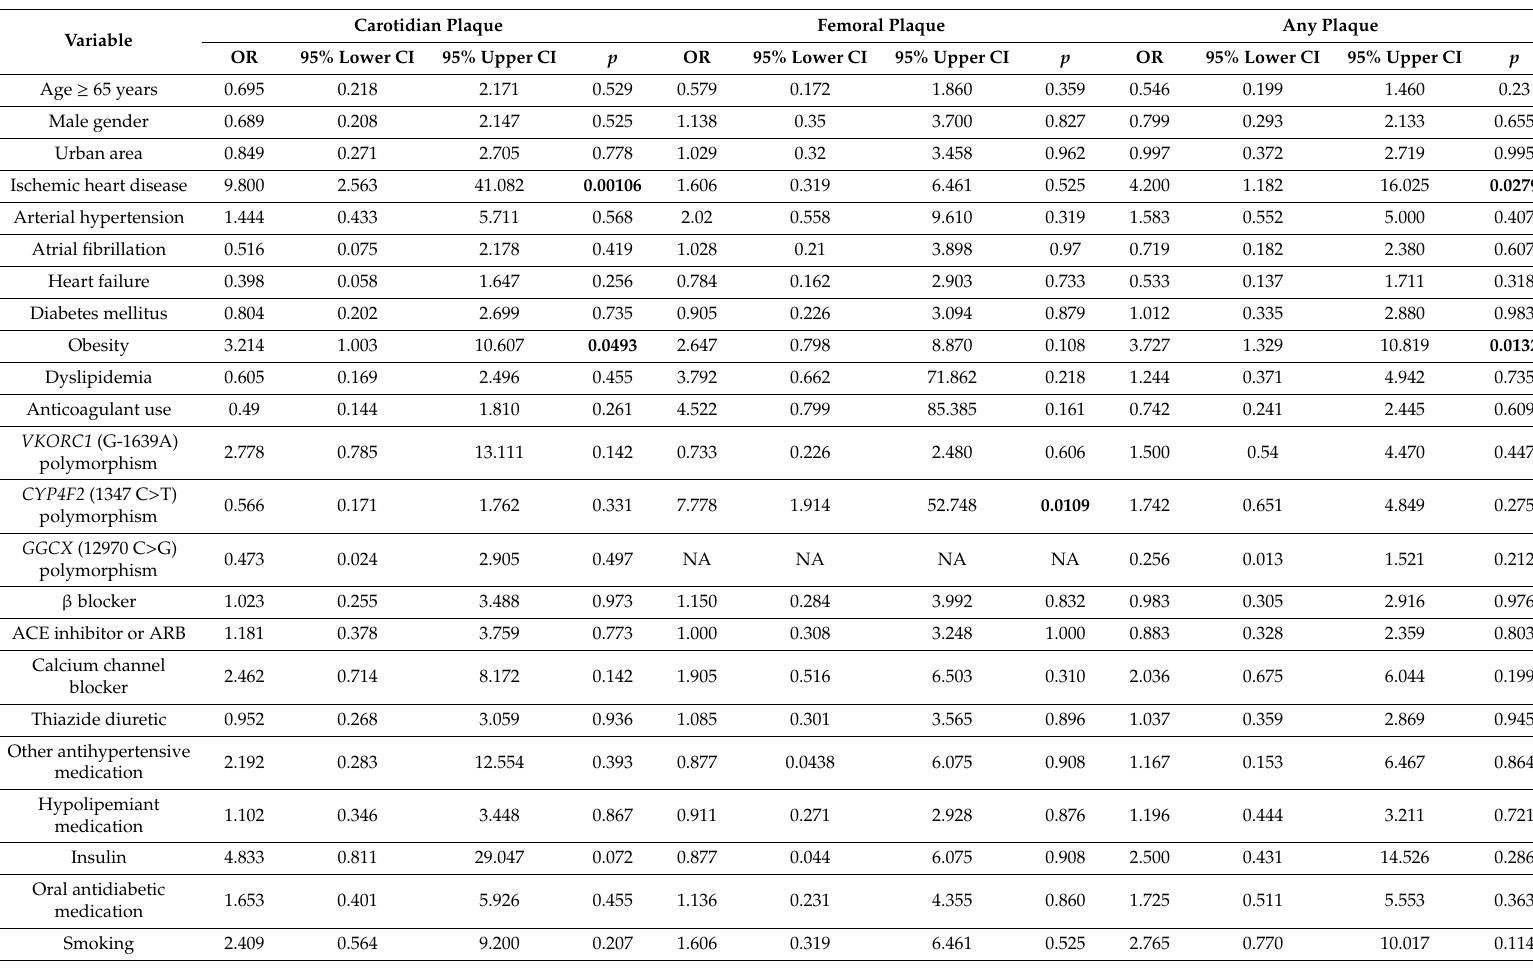
Table 2. Univariate logistic regression model for predicting carotid, femoral, or any of the two plaques. VKORC1 and CYP4F2 mutational status was dichotomized between no mutation and either monoallelic or biallelic mutation. p values were bolded if p < 0.05. ACE = angiotensin-converting enzyme. ARB = angiotensin II receptor